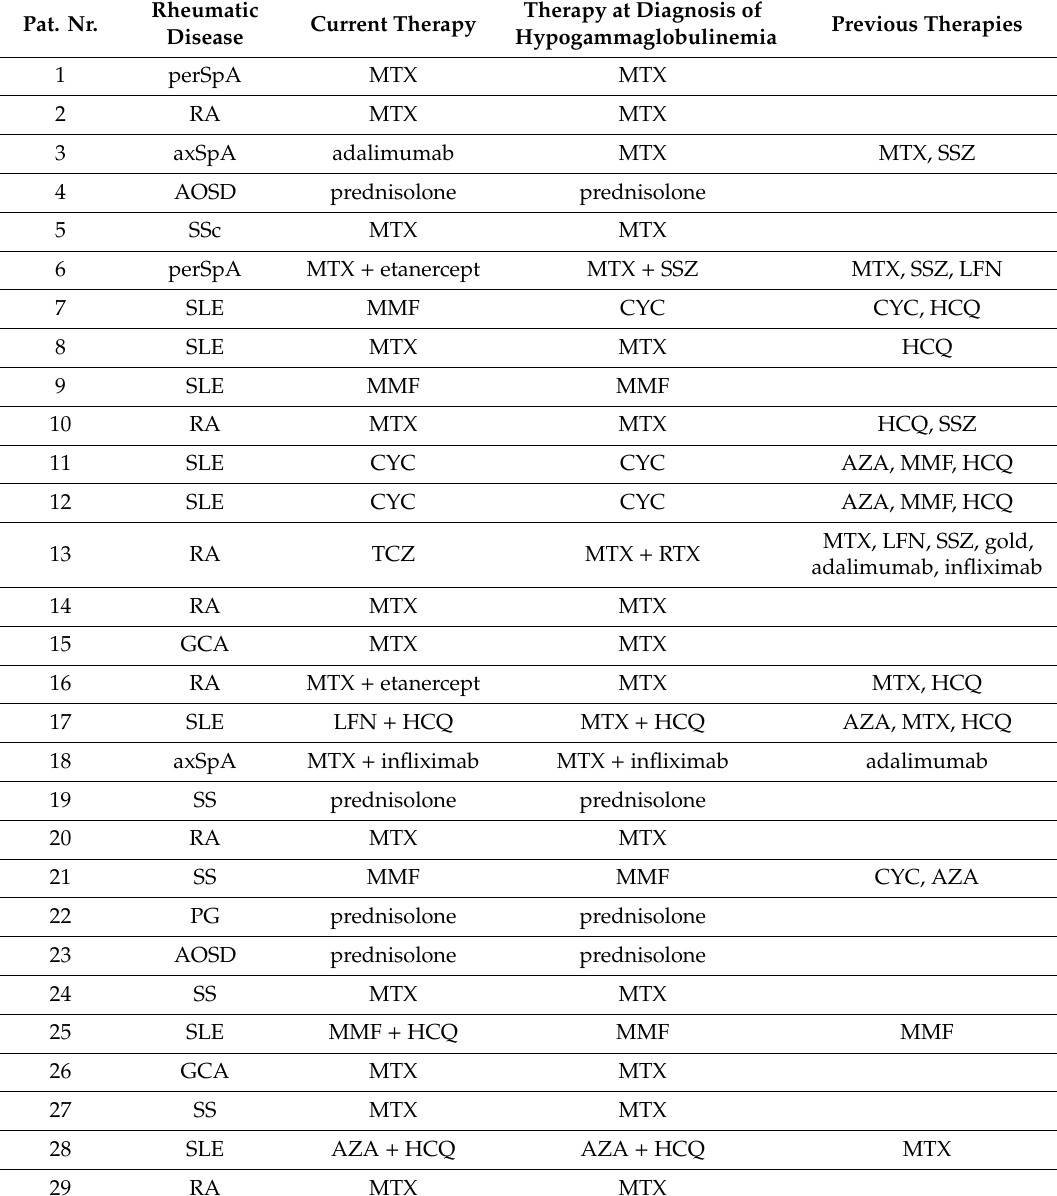
Table 2. Secondary hypogammaglobulinemia patients’ rheumatic disease, current and previous treatments. Prednisolone treatment is noted in case it is the only treatment. Pat.